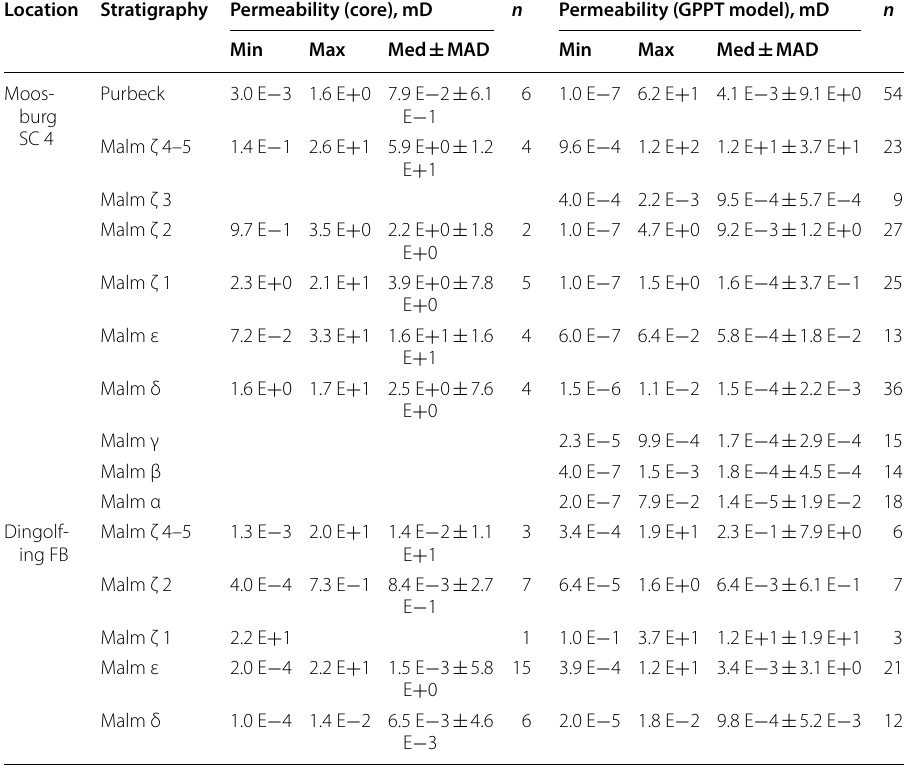
Min minimum, Max maximum, Med median, MAD median absolute deviation, n count